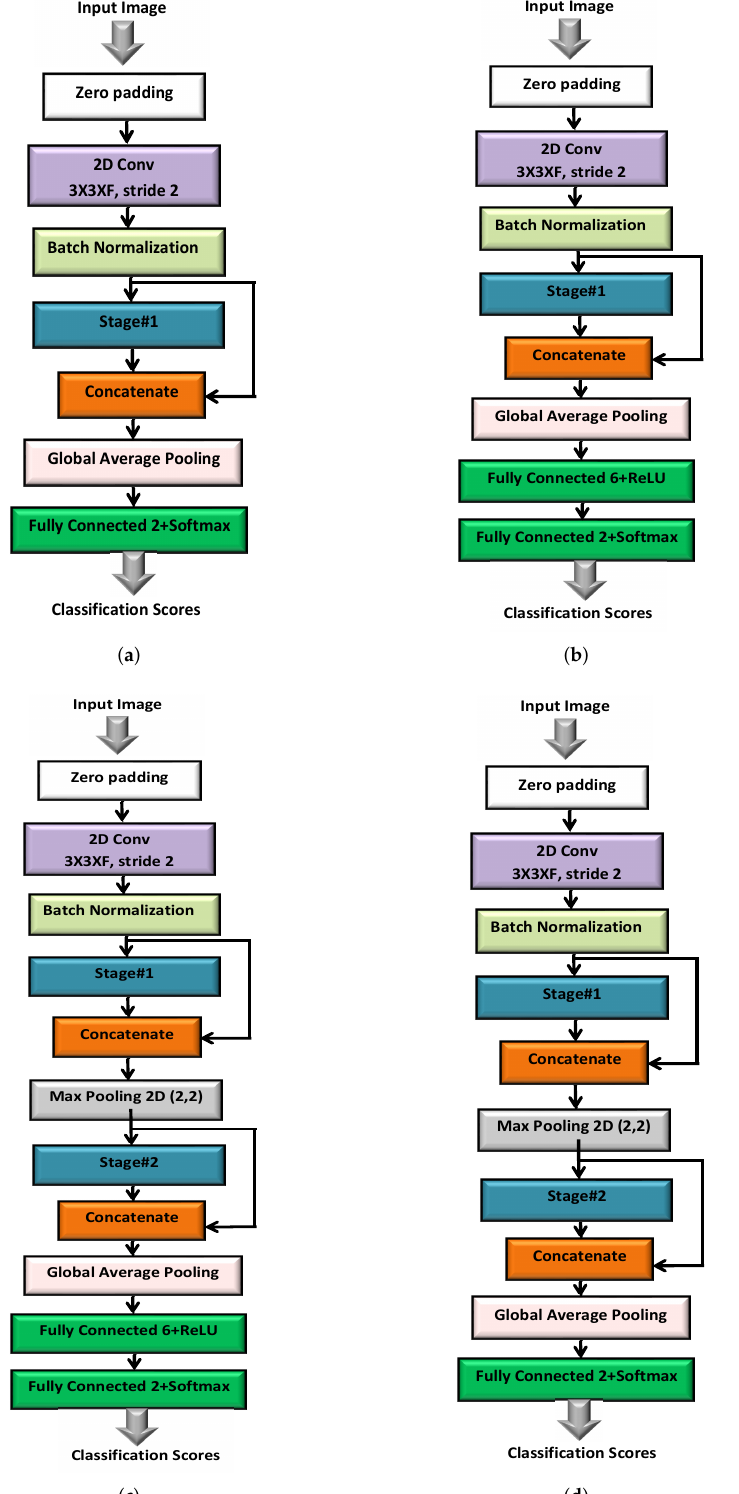
Figure 3. Different classifier models. ( a ) Thick ( F = 32) one-stage model; ( b ) Thin ( F = 16) one-stage model with a dense layer; ( c ) Thin ( F = 16) two stages model with a dense layer; ( d ) Thick (thin) two stages model, F = 32